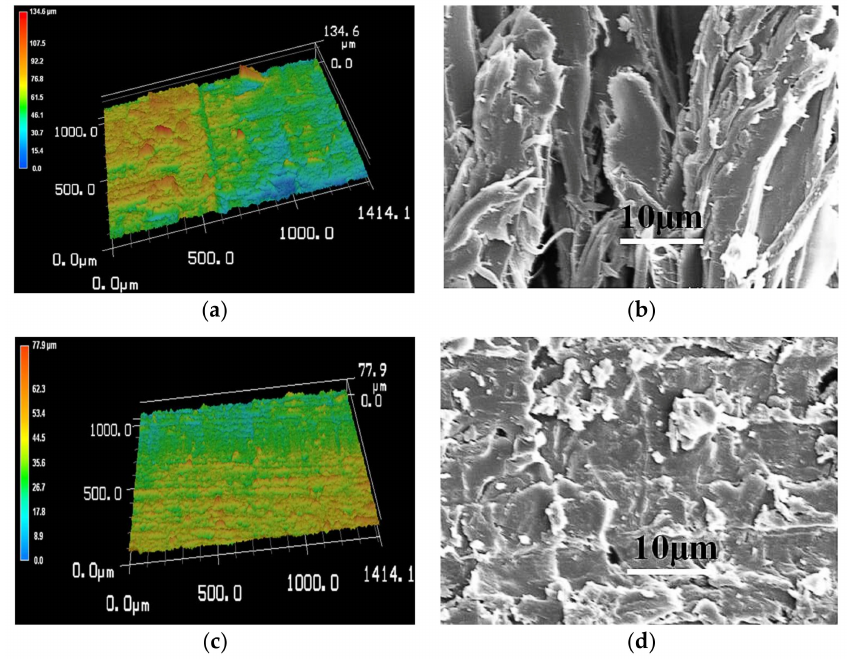
Figure 4. ( a ) OPM and ( b ) SEM images of SR-60 wood. ( c ) OPM and ( d ) SEM images of SR-320